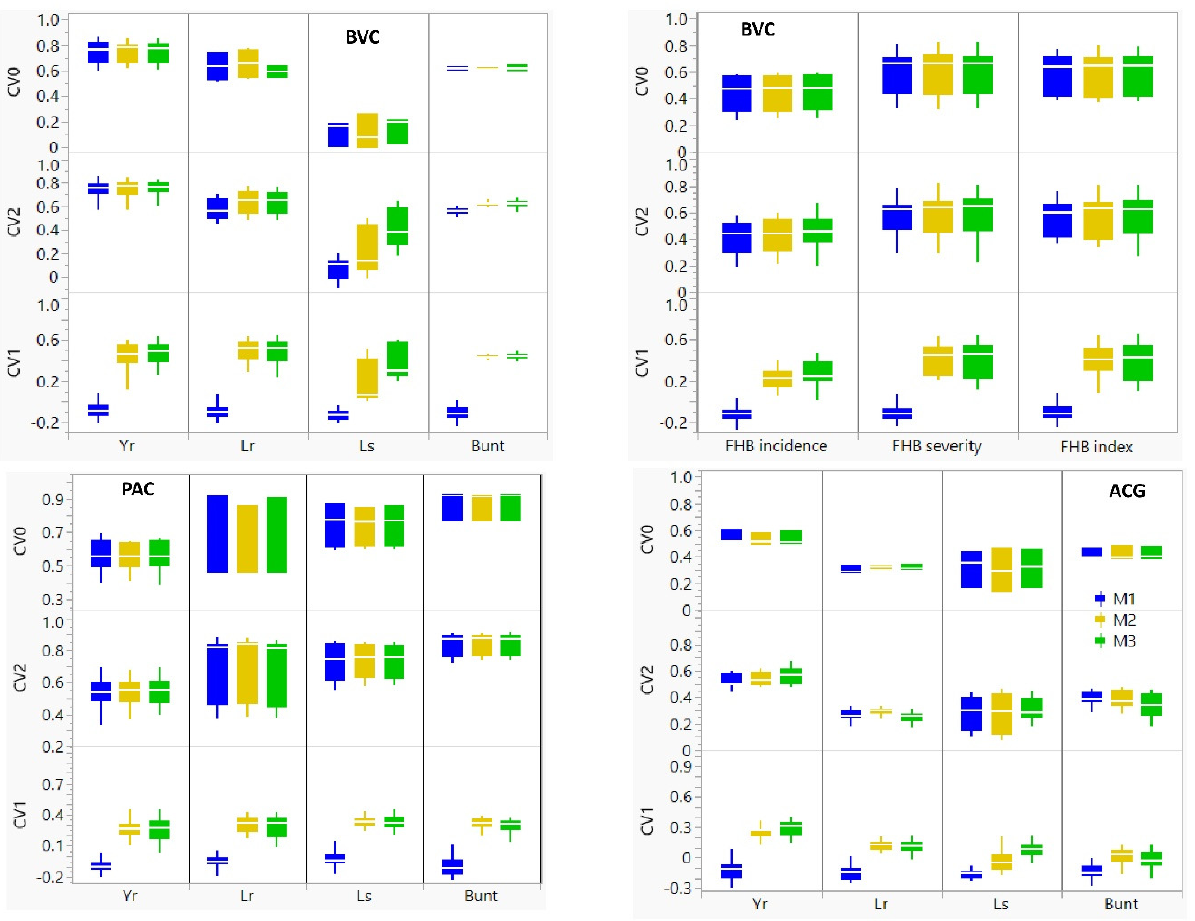
markers were incorporated in the M2 model, the average prediction accuracies per trait with the CV1, CV2, and CV0 schemes varied from 0.02 to 0.49, from 0.21 to 0.84, and from 0.11 to 0.87, respectively. The overall average prediction accuracies of all diseases and 1 BVC: association mapping panel; PAC and ACG: recombinant inbred lines derived from a cross populations obtained when the M2 model was used with the CV1, CV2, and CV0 schemes between Peace × Carberry, and Attila × CDC Go, respectively. 2 Yr: yellow (stripe) rust; Lr: leaf rust; were 0.28, 0.54, and 0.55, respectively. The prediction accuracies of the M3 model with the Ls: leaf spot; FHB: common bunt; FHB inc.: Fusarium head blight (FHB) incidence; FHB sev.: FHB CV1, CV2, and CV0 schemes varied from 0.02 to 0.48, from 0.25 to 0.84, and from 0.14 to severity. 3 Std: standard deviation of the mean. M1, M3, and M3 represent the baseline model, the 0.87, respectively. The average prediction accuracies with the M3 model were 0.30 for CV1 main effect reaction norm model, and the model that incorporated GE interactions, respectively. and 0.55 for both CV2 and CV0.